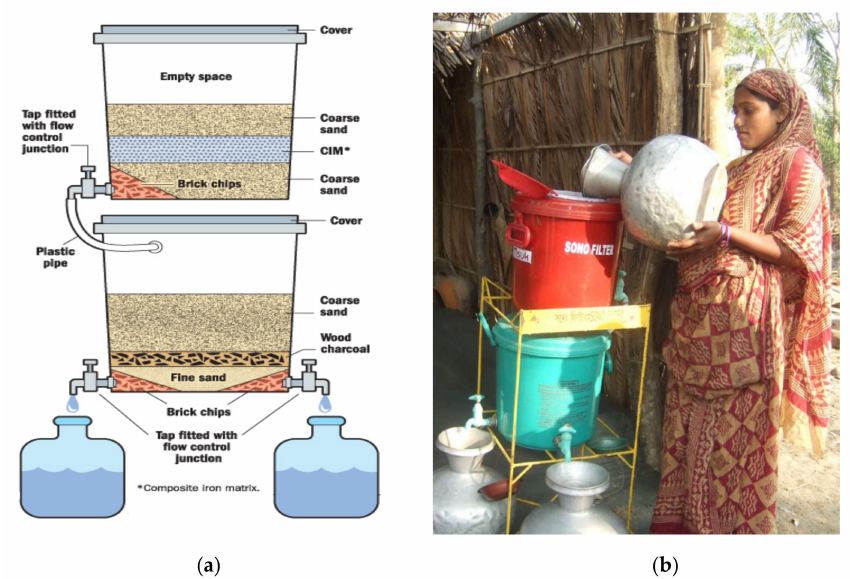
Figure 5. SONO Filter. ( a ) Schematic and ( b ) in domestic use [158]. Reproduced with permission from Taylor &